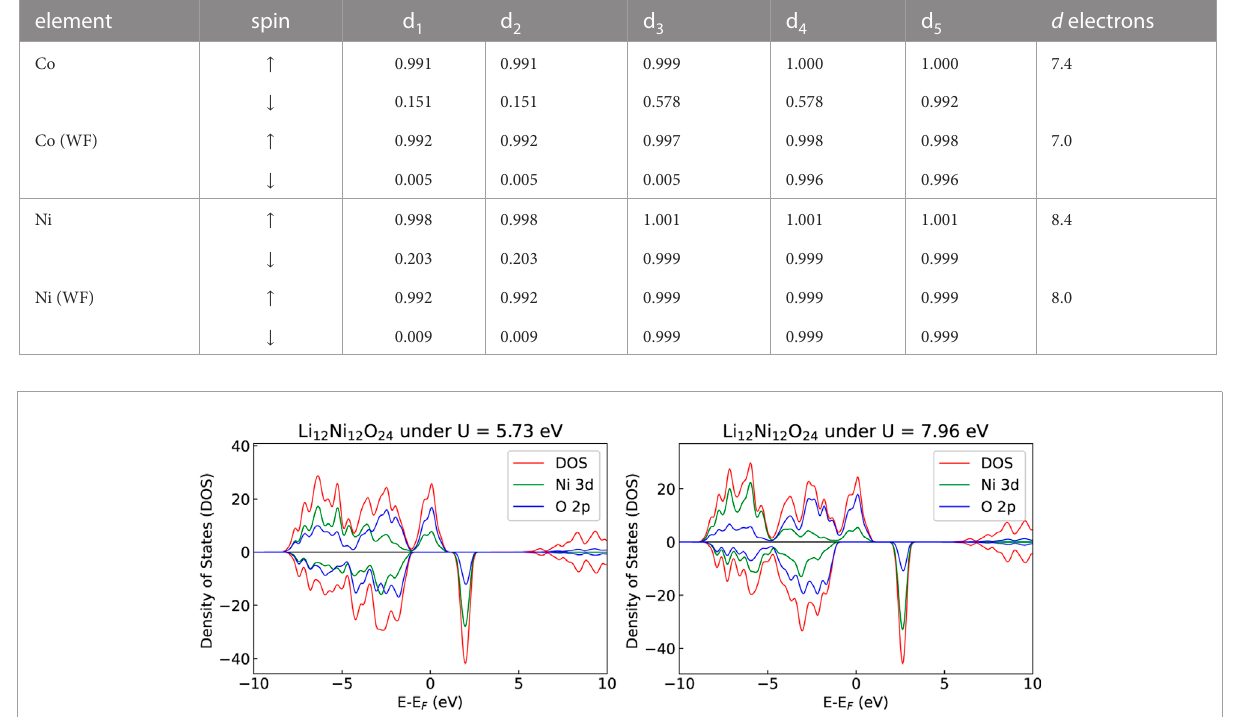
TABLE2 Theoccupanciesof3 d orbitalsobtainedwiththeatomicorbital-andWannierfunctions(WF)-basedprojectors.Theresultingnumberof d electronsisreportedinthelastcolumn. element